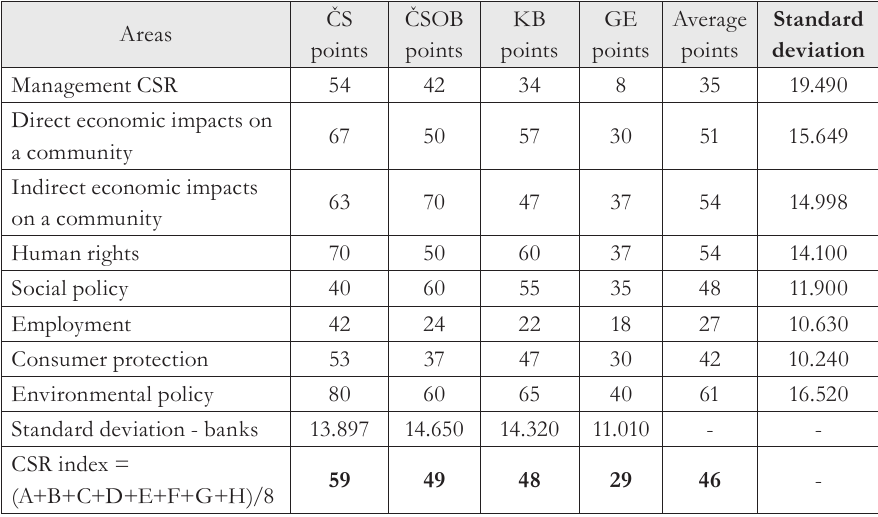
Tab. 9 - Summary of results according to evaluated areas. Source: